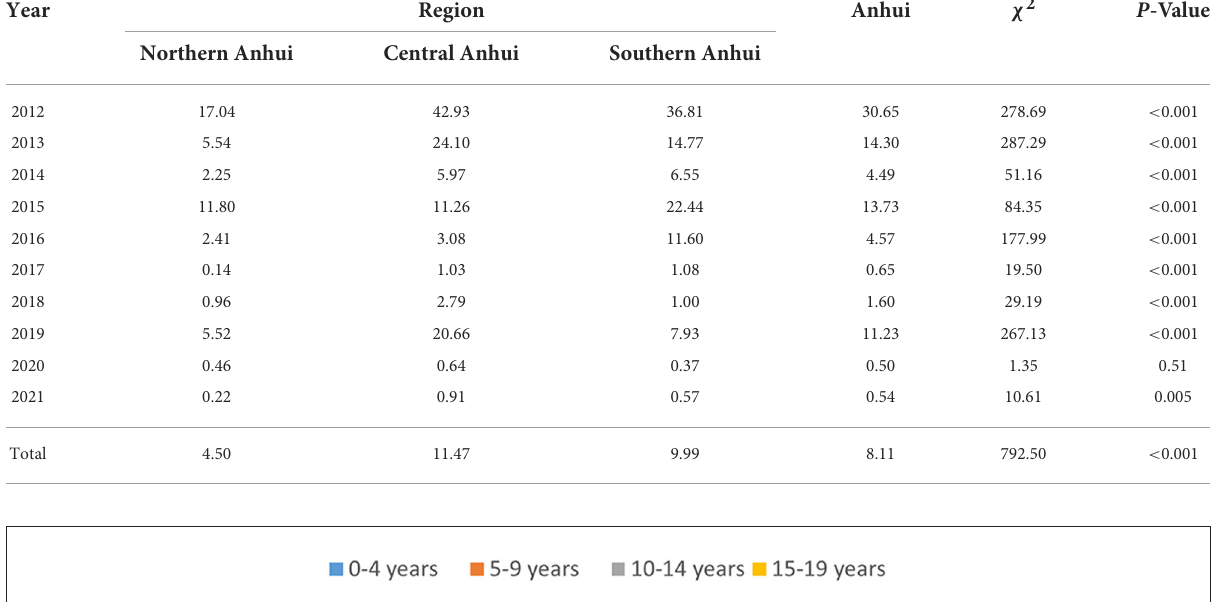
TABLE 1 Rubella Incidence by region in Anhui Province from 2012 to 2021 (per million).